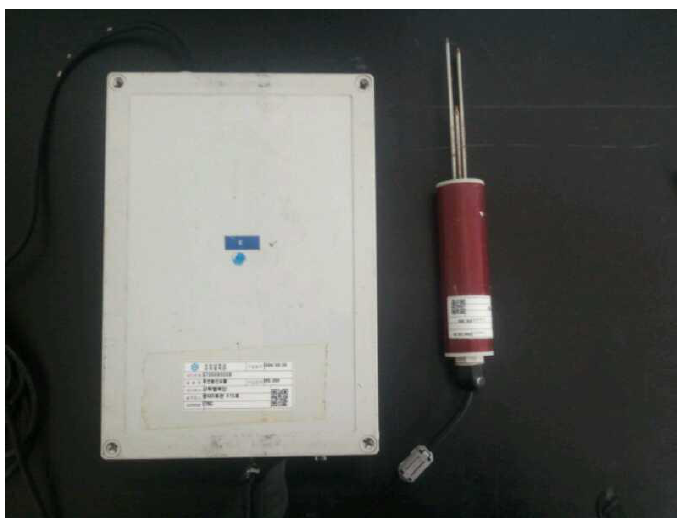
Figure 4. Soil sensor node.